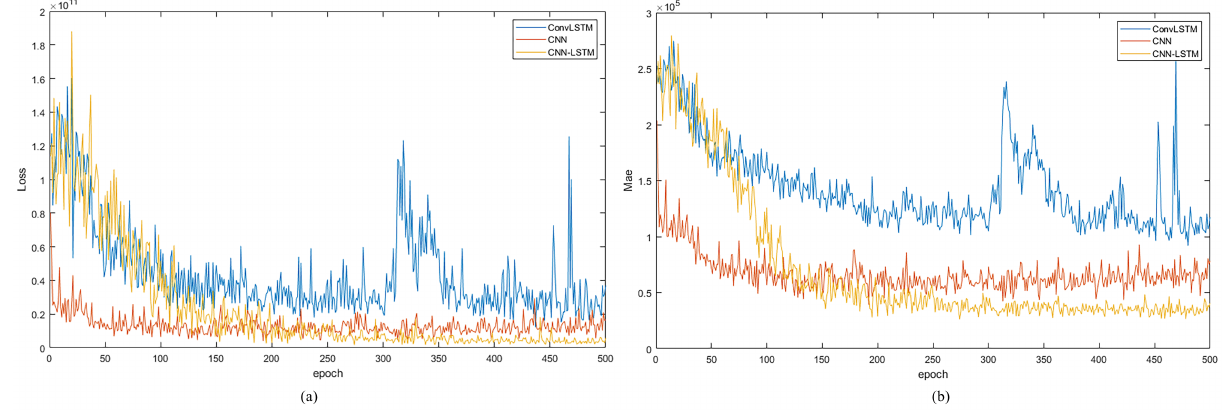
Figure 4. Loss and MAE of the three model validation sets. ( a ) is the validation set Loss, ( b ) is the validation set MAE.